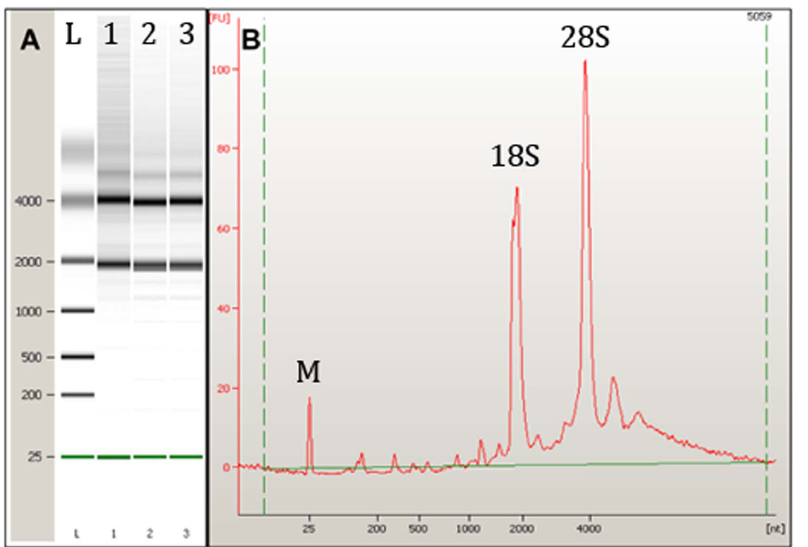
Figure 1. RNA quality control. A) Bioanalyser output of total RNA extracted from mouse skeletal muscle. (L) Ladder, (1 – 3) representative muscle samples. B) Example of Bioanalyser electropherogram of RNA, (M) marker, 18S and 28S ribosomal RNA peaks.